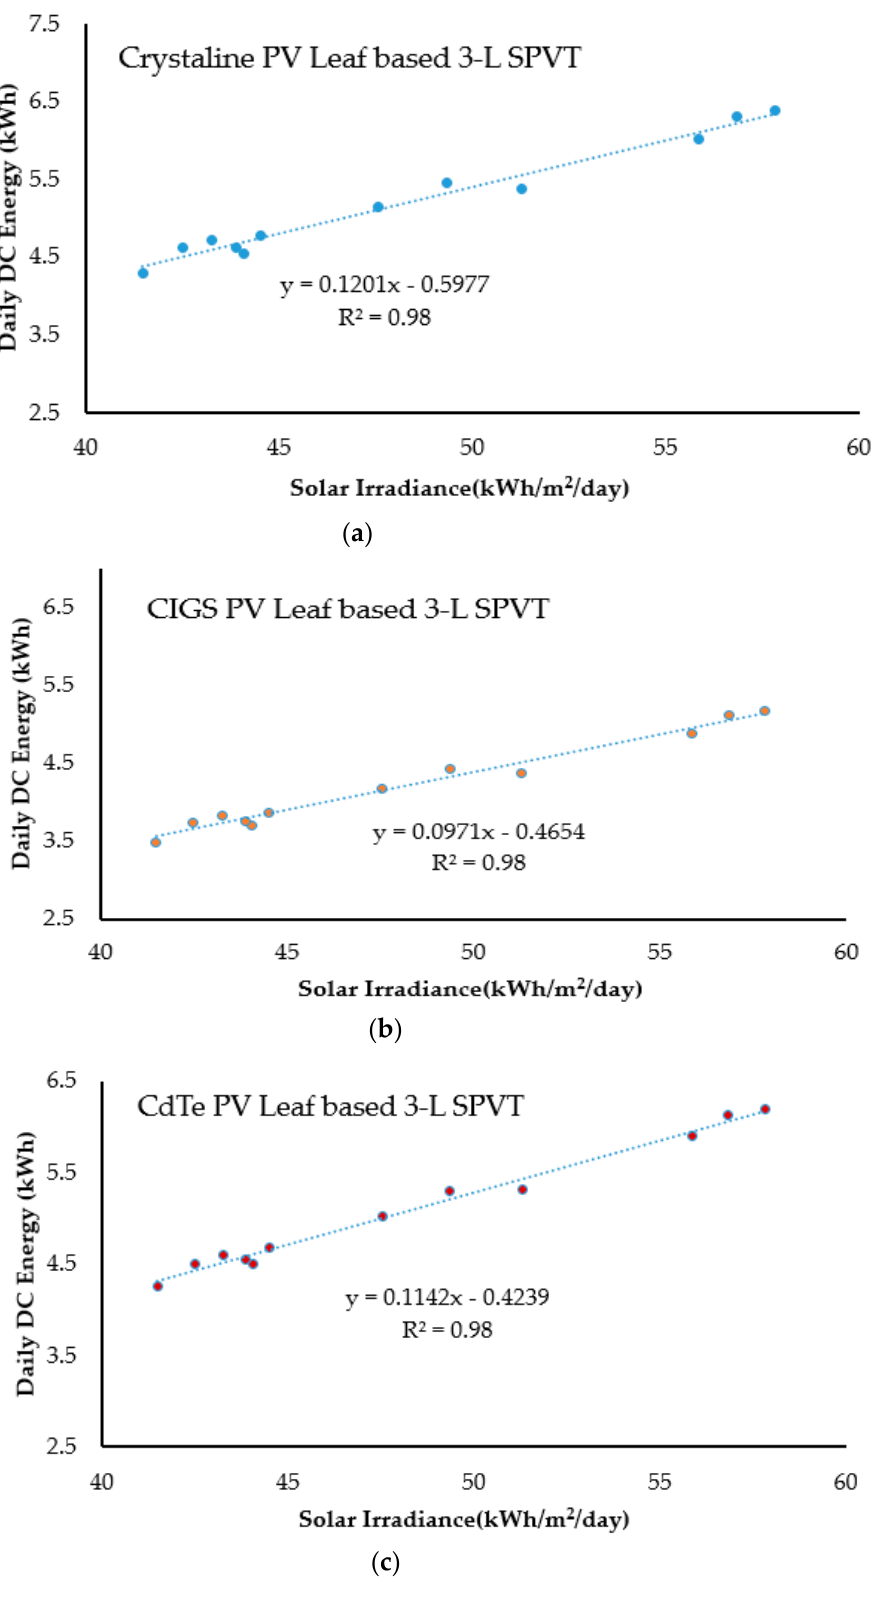
Figure 7. Relationship between the energy outputs and the incident solar irradiance ( a ). c-Si PV-leaf based 3-L SPVT; ( b ) CIGS PV-leaf based 3-L SPVT; ( c ) CdTe PV-leaf based 3-L SPVT.